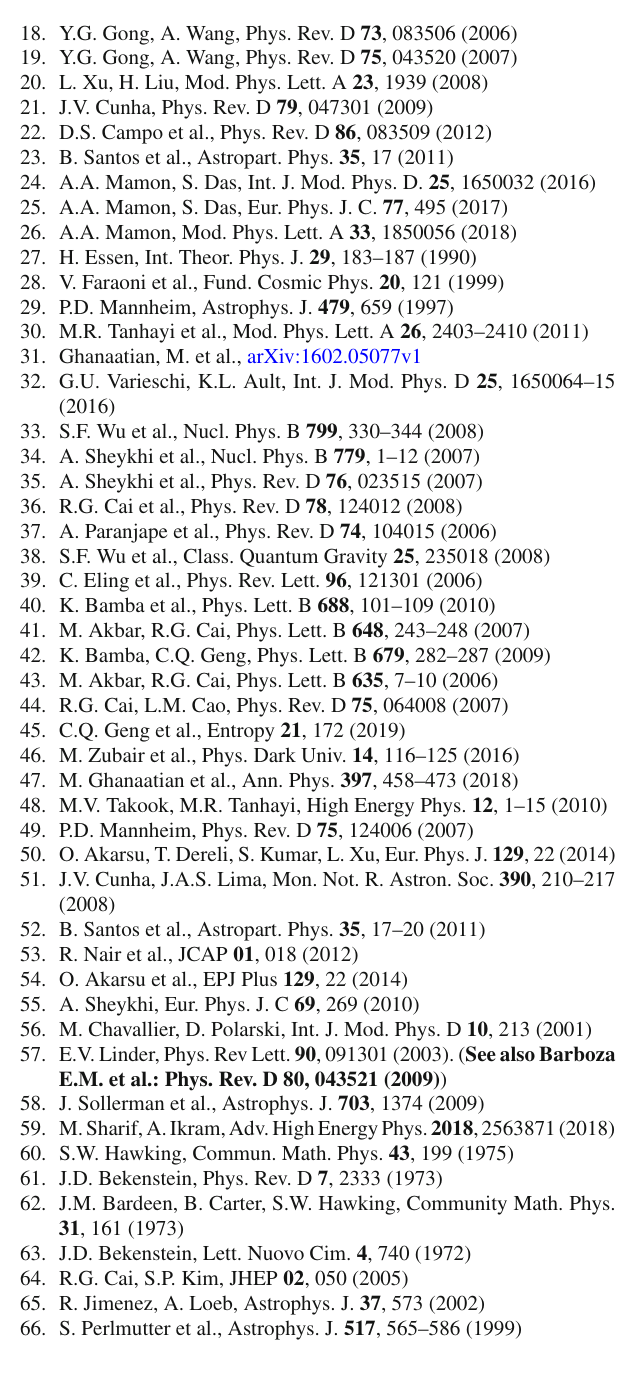
Table 2 Results of the cosmological parameters, GSLT and thermal equilibrium condition Models of H(z) ω ef f v 2 s GSLT Thermal condition Model 1 Quintessence region to vacuum region Stable Partially valid Satisfy Model 2 Quintessence region to vacuum region Stable Valid Partially satisfy Model 3 Quintessence region Stable Valid Satisfy Model 4 ( (cid:2) CDM model) Quintessence region to vacuum region Stable Valid Partially